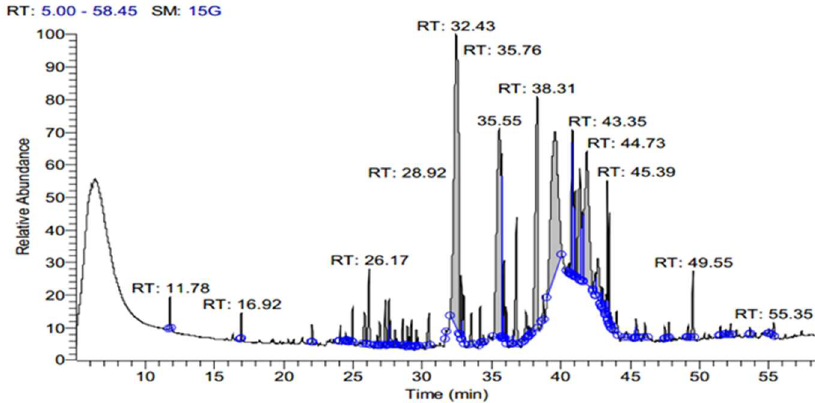
Figure 1. GC-MS Chromatogram of S. costus extract by SFE at a pressure of 10 MPa (E10).